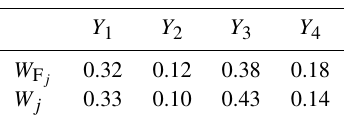
) and non-fuzzy-based ( W j ) weights for the j